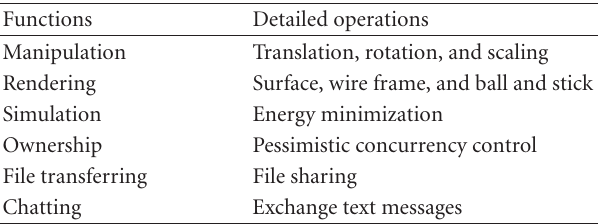
Table 1: Supporintg functions in VRMMS.